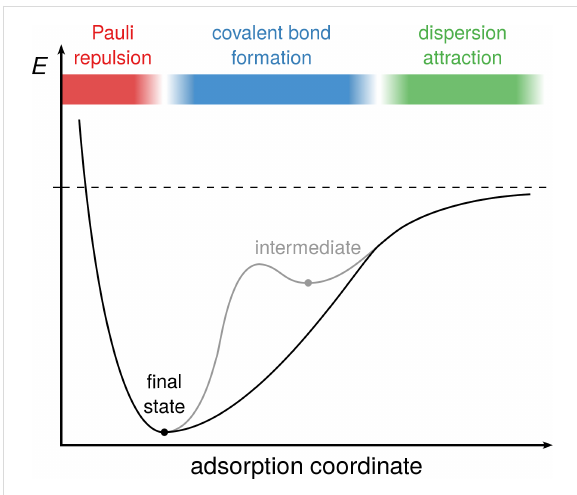
Figure 1: Adsorption energy profile of a direct adsorption (black, e.g., cyclooctyne/Si(001)) in comparison with adsorption via an intermedi- ate (grey, e.g., methanol/Ge(001)). On top, the dominant type of inter- action in the different regimes of the profile is given.